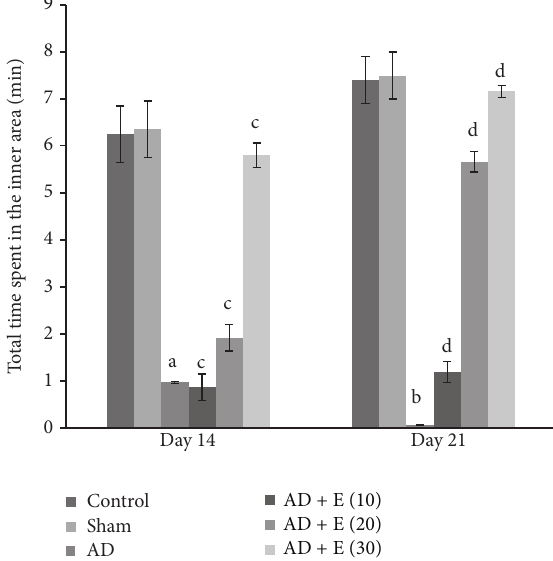
Figure 2: The total time spent in the inner area in an elevated open space with a novel object (for anxiety status) of different experimentalgroupsofrats. a cADversuscontrol/shamoperatedrats at day 14 ( 𝑝 < 0.001 ), b cAD versus control/sham operated rats at day 21 ( 𝑝 < 0.001 ), c cAD versus etoricoxib treated cAD at all the doses at day 14 ( 𝑝 < 0.001 ), and d cAD versus etoricoxib treated cAD at all the doses at day 21 ( 𝑝 < 0.001 ). Abbreviations are the same as in Figure 1. Values are expressed in mean ± SEM ( 𝑛 = 6 in each